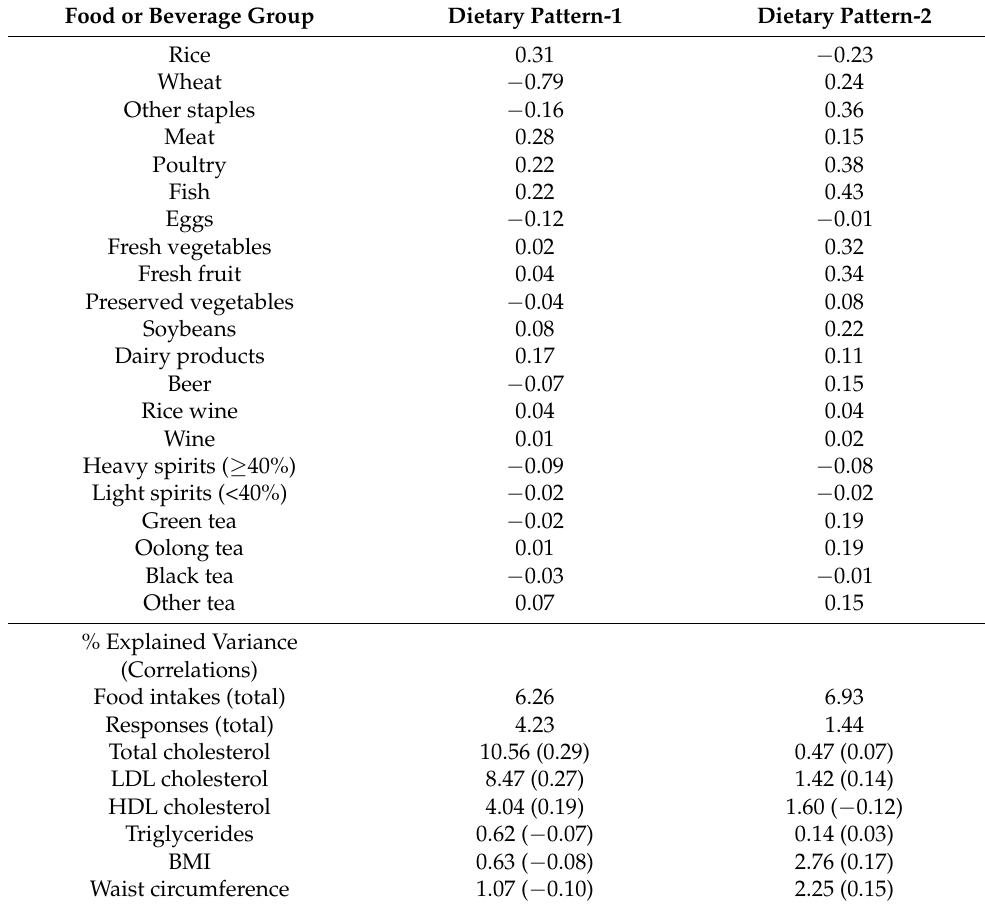
Table 1. Factor loading matrix of dietary patterns derived from a reduced rank regression from 17,318 participants from the second resurvey of the China Kadoorie Biobank. Food or Beverage Group Dietary Pattern-1 Dietary Pattern-2 Rice 0.31 − 0.23 Wheat − 0.79 0.24 Other staples − 0.16